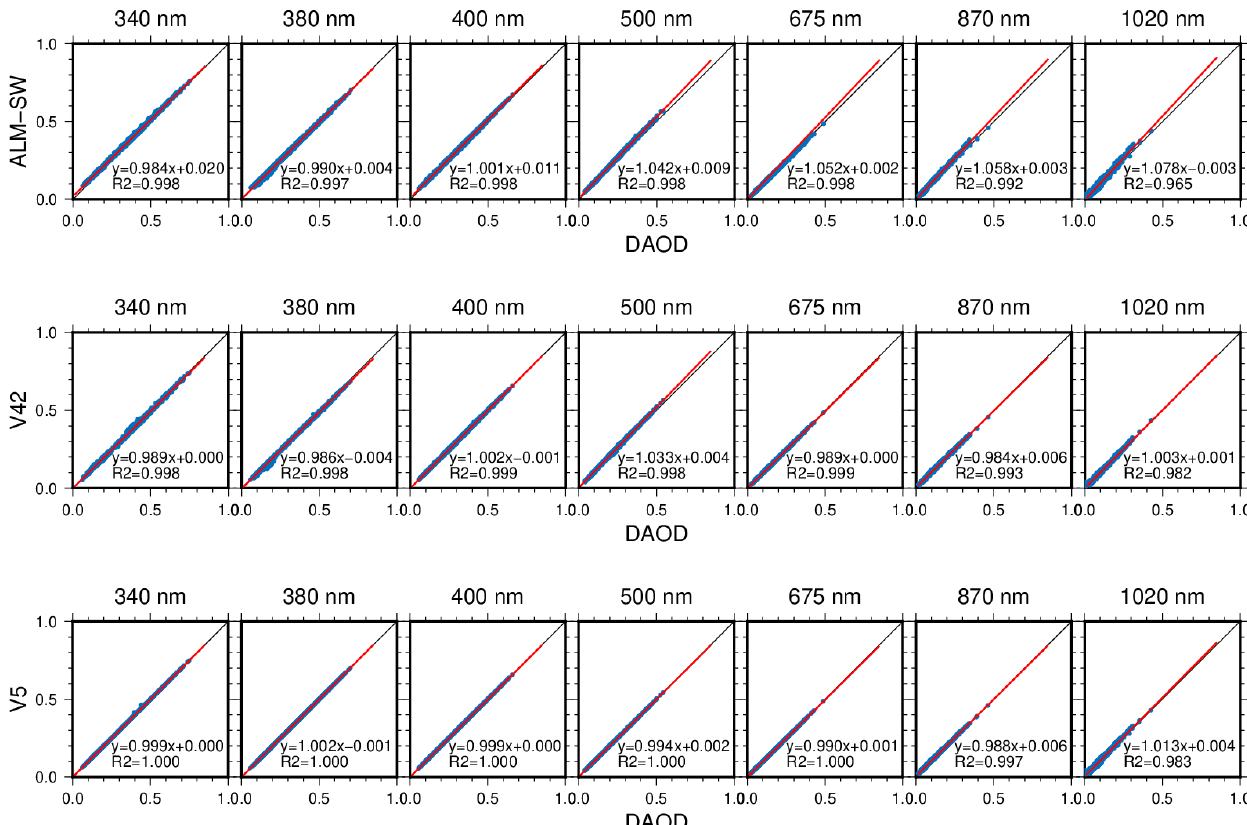
Figure 9. Comparisons of aerosol optical depth of ALM-SW, V42, and V5 with the aerosol optical depth derived from the direct irradiance (DAOD). The aerosol optical depths of ALM-SW, V42, and V5 are calculated from the retrieved size distribution and refractive index; y = ax + b and R2 are the linear fitting and the coefficient of determination for all the